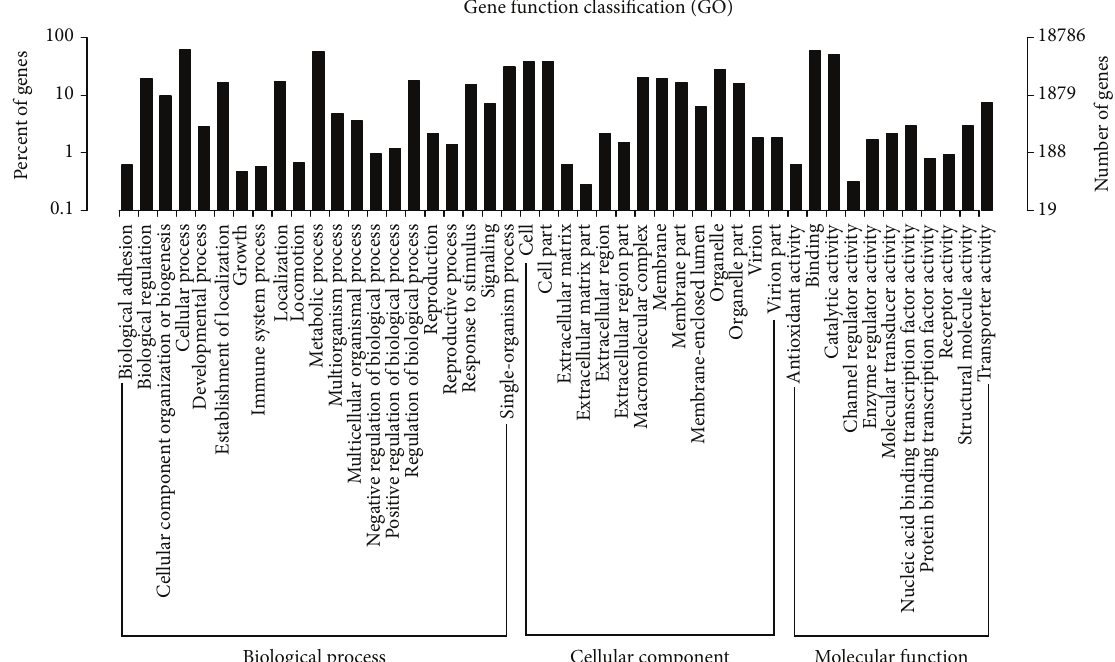
Figure 1: Histogram of gene ontology (GO) classification. The results are summarized in three main categories: biological process, cellular